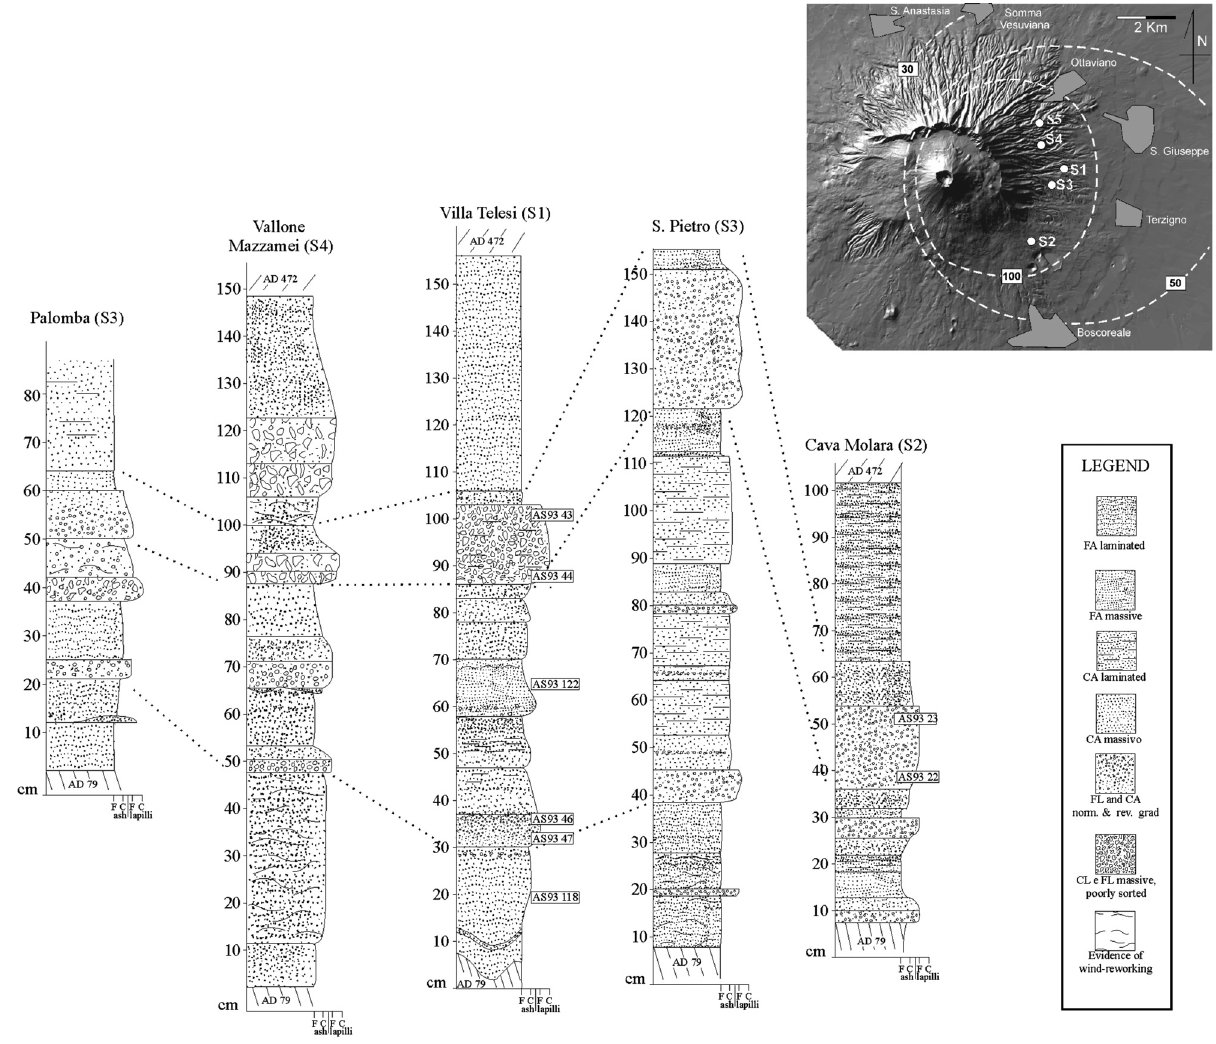
Figure 3. Lateral stratigraphic variations between the main sections of SMM deposits. The inset in the right upper corner shows the dispersal of the total deposit and the locations of the studied